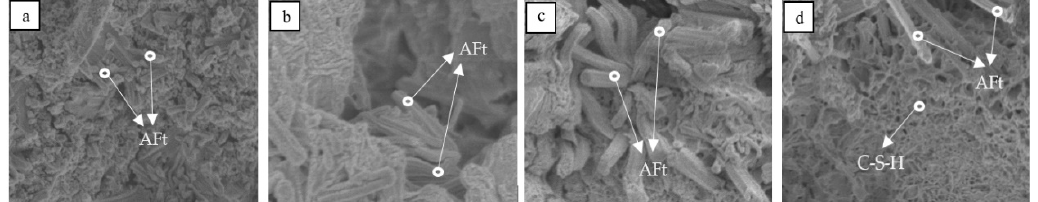
Figure 12. SEM micromorphology of the hydration products of the Series II cement clinker at di ff erent curing ages: ( a ) 1 day; ( b ) 3 days; ( c ) 7 days; ( d ) 28